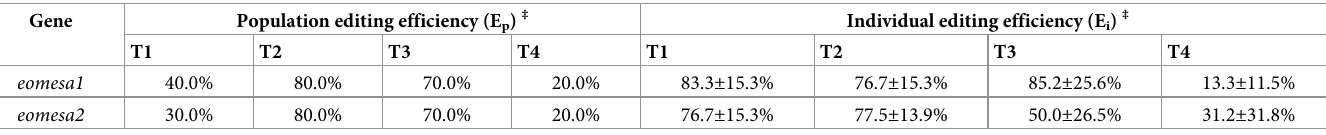
Table 3. The statistics of the knockout efficiency on larvae at 7dpf.